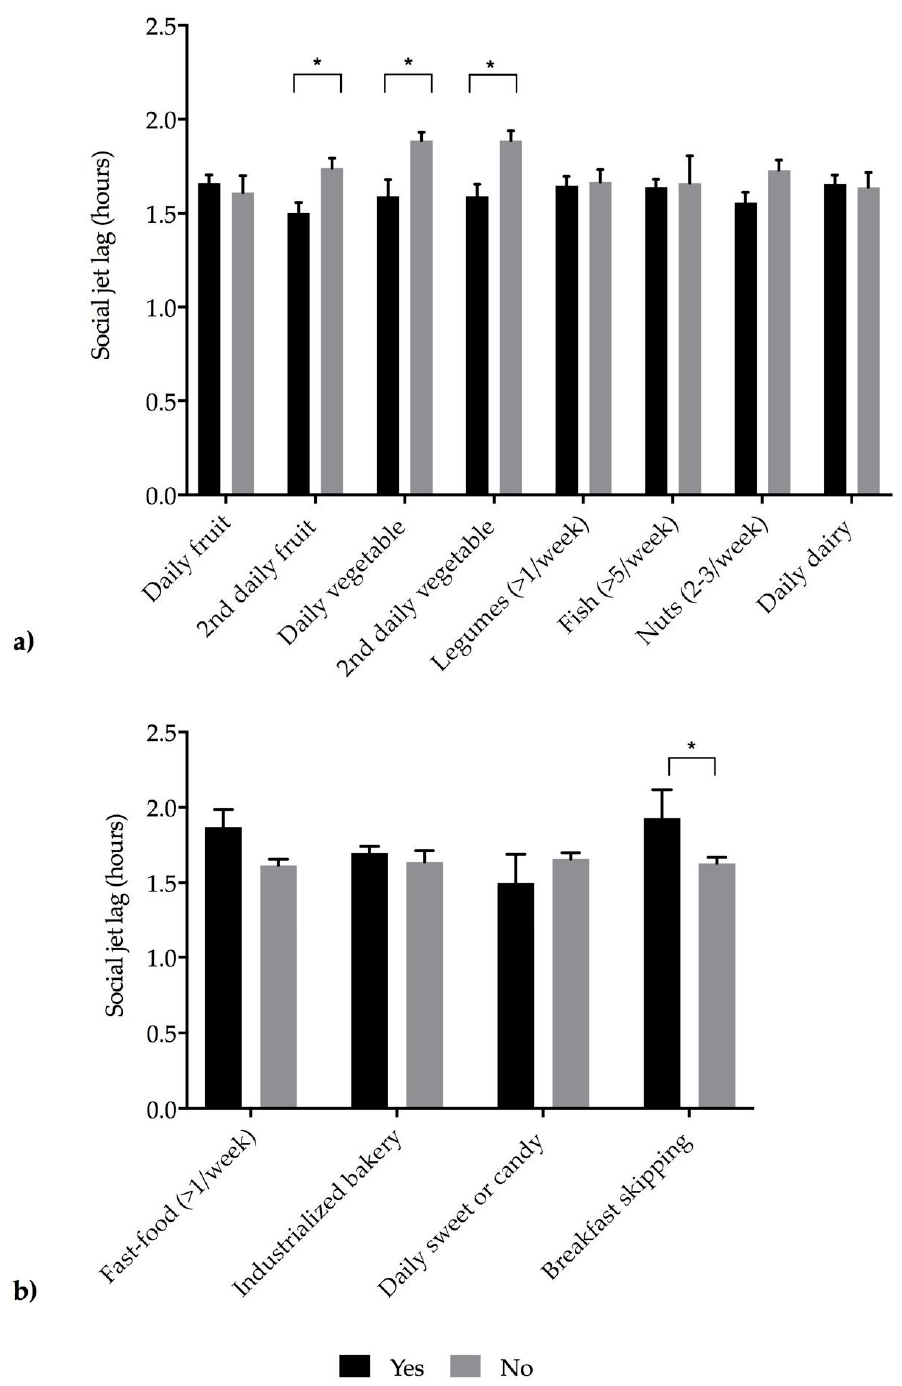
Figure 1. Social jet lag (in hours) and accomplishment or not of the KIDMED items. KIDMED, Mediterranean Diet Quality Index. Figure ( a ) shows healthy food groups, and ( b ) unhealthy dietary habits. Bars indicate mean values (standard deviations). Black bars represent the consumption of food group or dietary habits, and grey solid bars show lack of consumption of a food group or dietary habit. Data were analyzed using ANCOVA tests, adjusted by the following covariates: age, gender and physical activity. Significant p -values * <